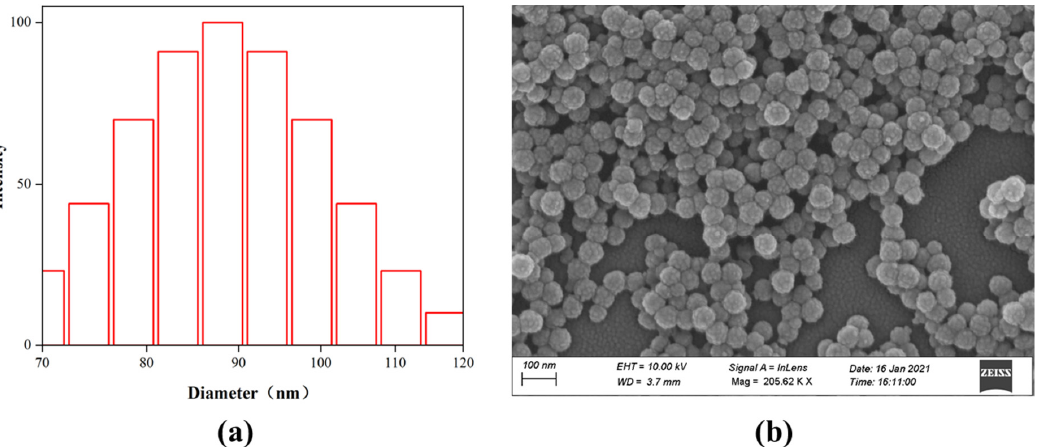
Figure 5. ( a ) The particle size distribution of the fluorinated nanoparticles. ( b ) The surface morphol- ogy of the fluorinated nanoparticles.